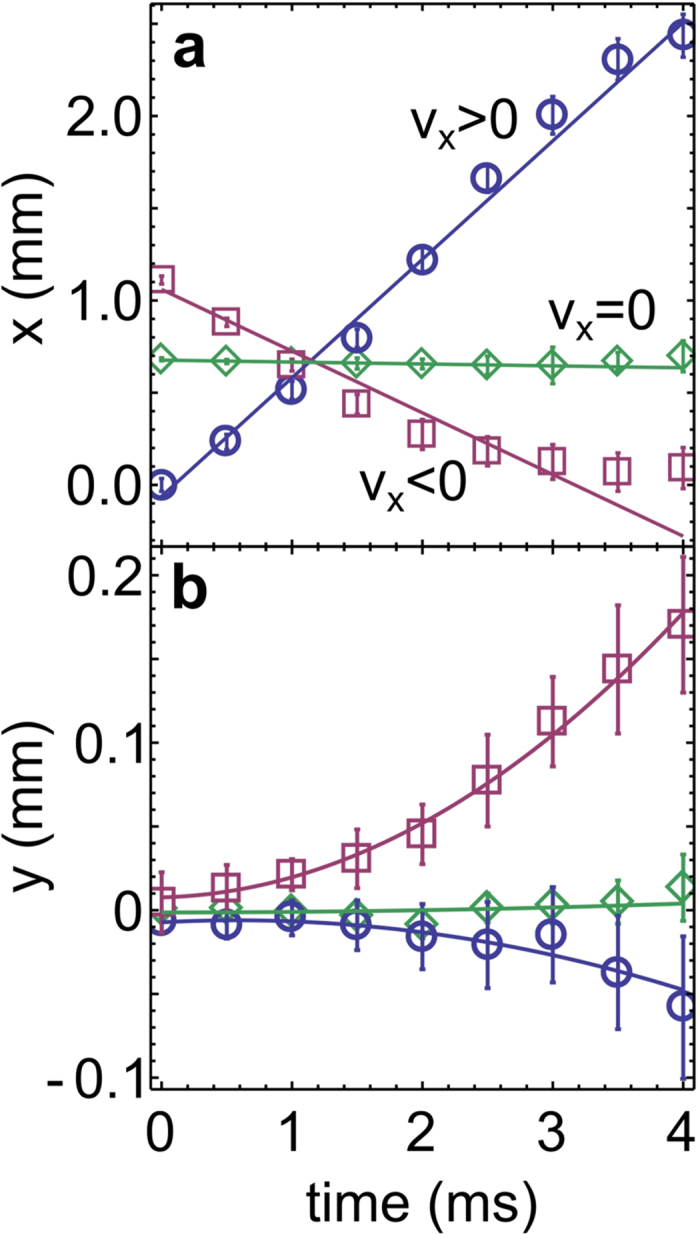
The trajectories of the CM of the atomic cloud in the presence of the synthetic Lorentz force.(a) x(t), and (b) y(t) for three different initial velocities, vx = 0.6 m/s >0 (circles), vx = −0.3 m/s <0 (squares), and vx = 0 m/s (diamonds); initial component of vy = 0 in all measurements. Accelerating motion along y is the signature of the transverse force Fy, which depends on vx. The lines are fitted to the experimental data, linear fits for vx(t), and quadratic for vy(t).